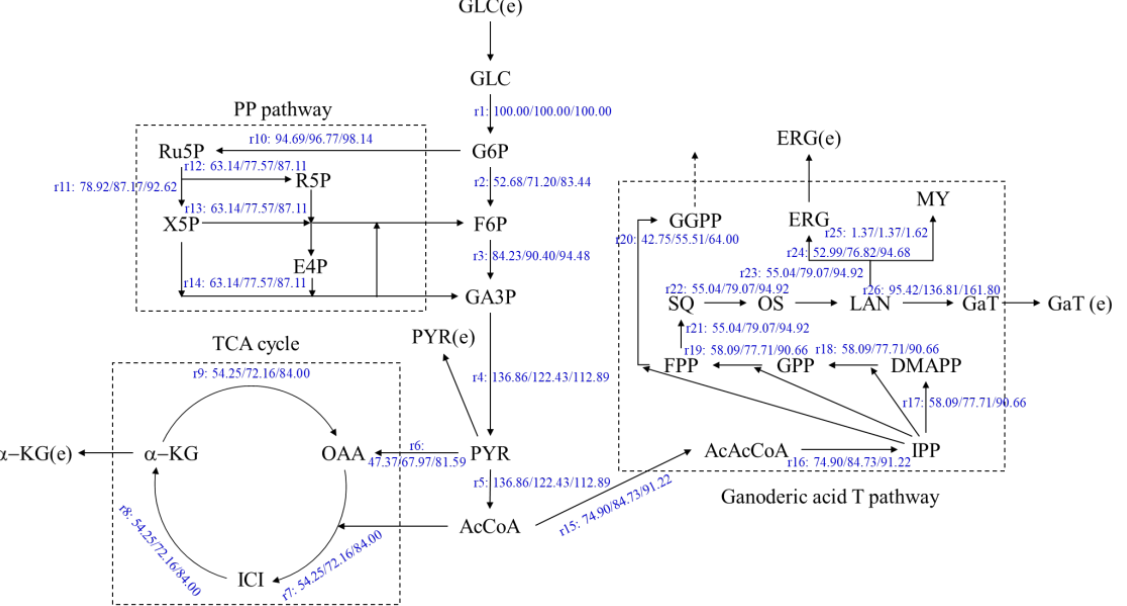
Figure 5. Metabolic flow distribution of ganoderic acid T, synthesized by submerged fermentation- static culture under two methods of oleic acid addition. Left : Control (the 20th day of static culture); Middle: Filtration-sterilization oleic acid (20 days of static culture); Right : High-temperature-steri- lization oleic acid (10 days of static culture).